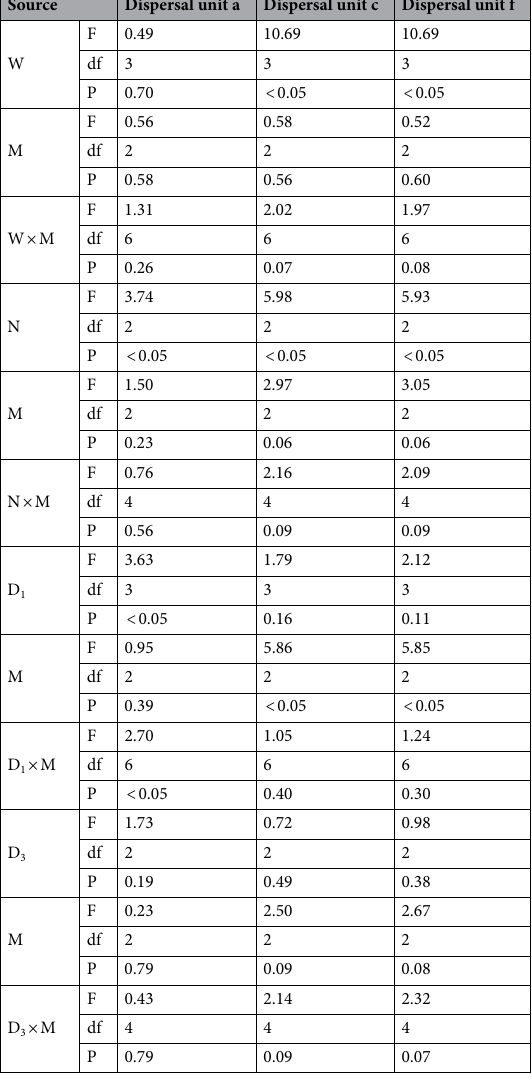
Table 1. Summary of two-way ANCOVAs showing effects of different levels of water (W), nutrient availability (N), pure (D 1 ) or mixed (D 3 ) density, plants from the three dispersal unit morphs (M) and their interactions on proportion of each dispersal unit morph from offspring of Ceratocarpus arenarius . There was no significant effect of initial seedling size, which was used as a covariate, on any of the variables in the analyses (data not